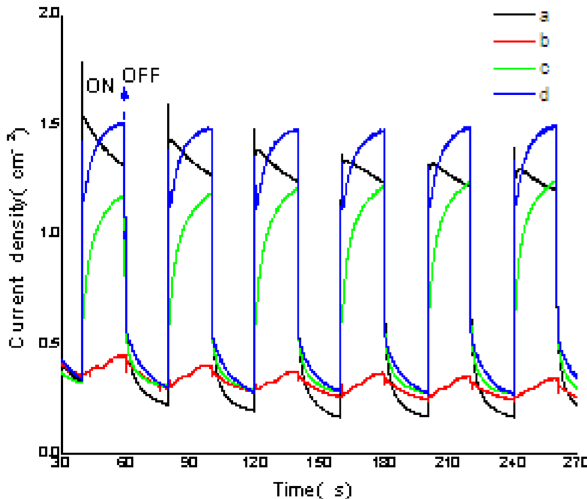
Figure 12: Transient photocurrent responses of composites: pure CNTs ( a ) , GCB ( b ) , GCC ( c ) , and GCBC ( d ) .